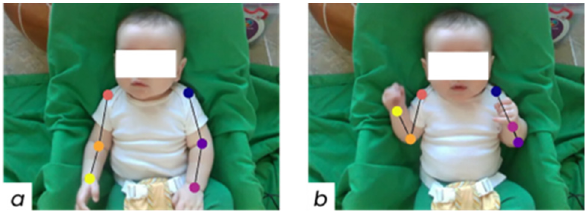
Figure 3. ( a ) RE is identified in the middle between epicondyles and ( b ) RE is positioned on the medial epicondyle. Subjects are made unidentifiable by using white patches. The coloured circles represent PoIs.